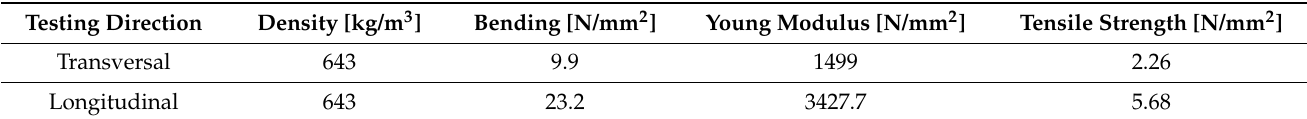
Table 8. Mechanical properties of the 8 mm OSB